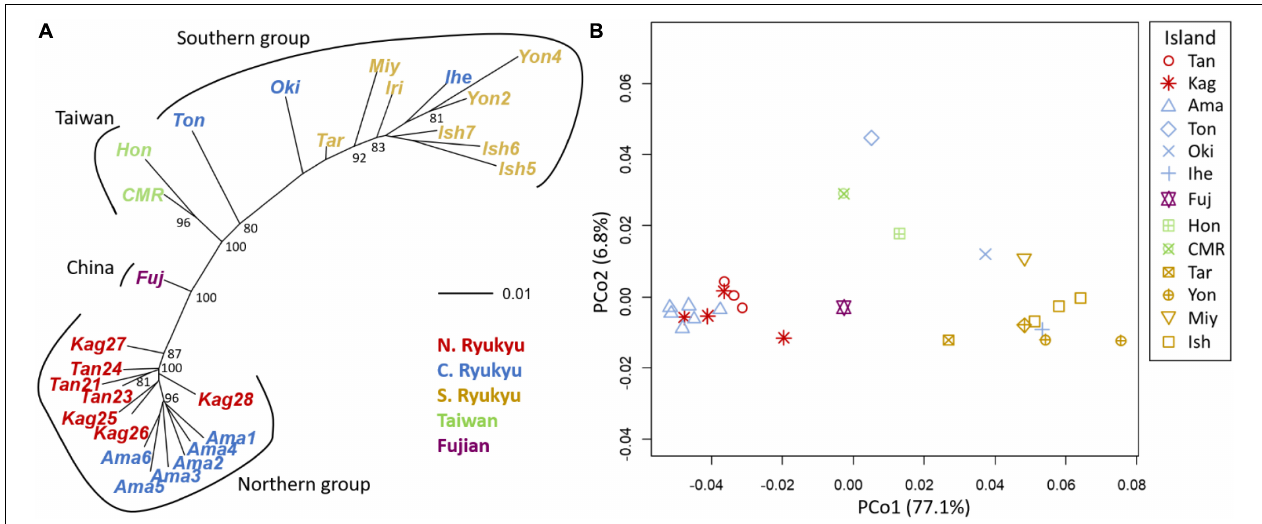
FIGURE 6 | Population genetic structure inferred by (A) the neighbor-joining tree and (B) principal coordinate analysis (PCoA) by Nei’s distance. The island names are abbreviated as the first three characters of the full names, except for CMR (Coastal Mountain Range). Within-island populations are listed in Supplementary Table 1